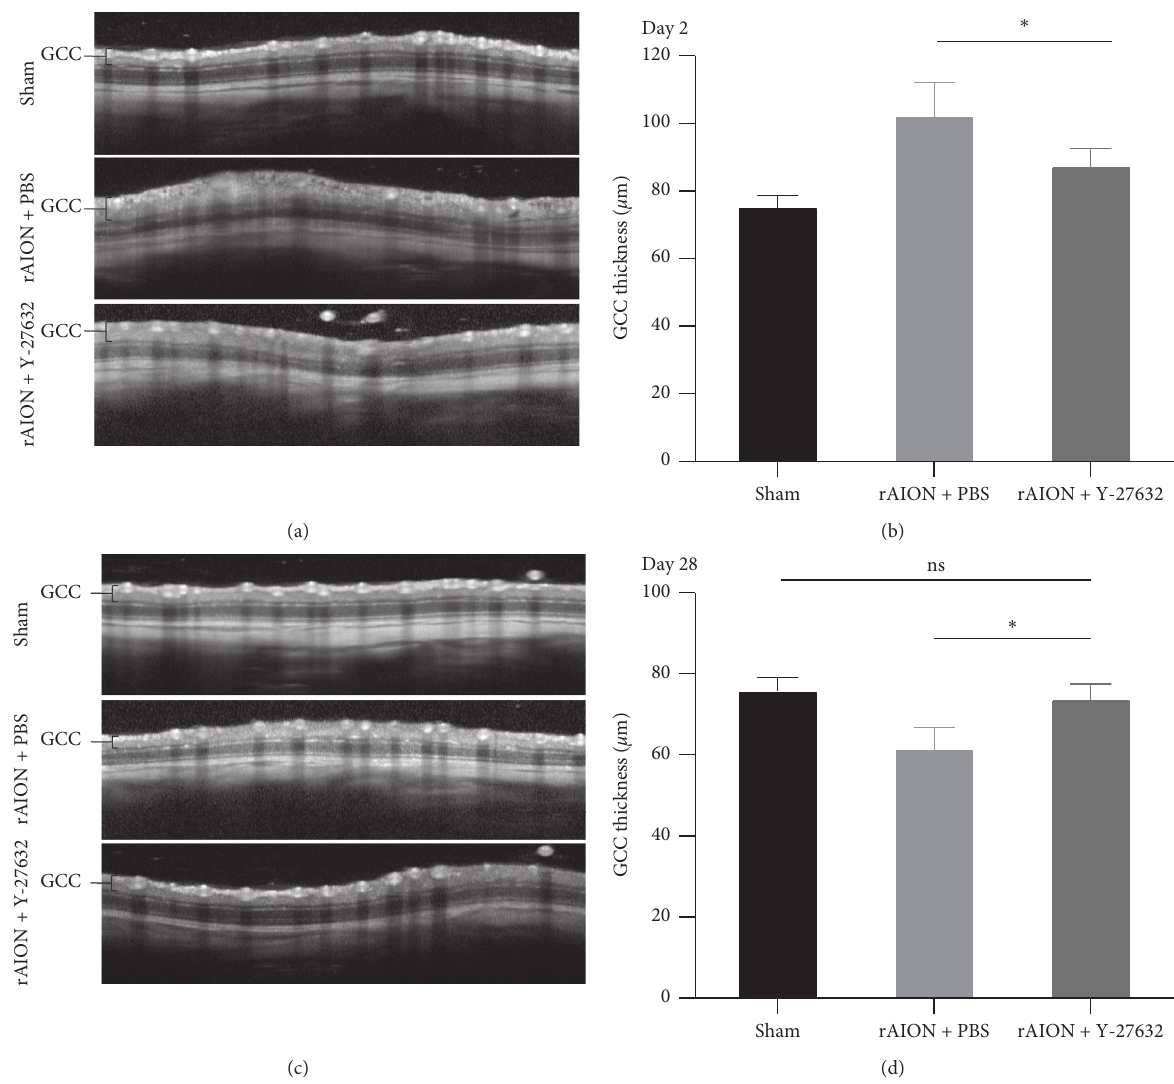
Figure 2: Cross-sectional OCT images displaying GCC thickness at 2 days and 28 days after induction. (a) Circular scan around the optic disc showing GCC thickness at 2 days after induction. (b) Quantification of GCC thickness at 2 days after induction. The mean GCC thickness in the Y-27632-treated group was significantly lower than that of the PBS-treated group at day 2 ( n � 12 per group). The asterisk indicates p < 0 . 05, as determined by the Kruskal–Wallis test. (c) Circular scan around the optic disc showing GCC thickness at 28 days after induction. (d) Quantification of GCC thickness at 28 days after induction. The mean GCC thickness in the Y-27632-treated group was significantly higher than that of the PBS-treated group after 28 days but was not significantly different from that of the sham group ( n � 12 per group). The asterisk indicates p < 0 . 05, as determined by the Kruskal–Wallis